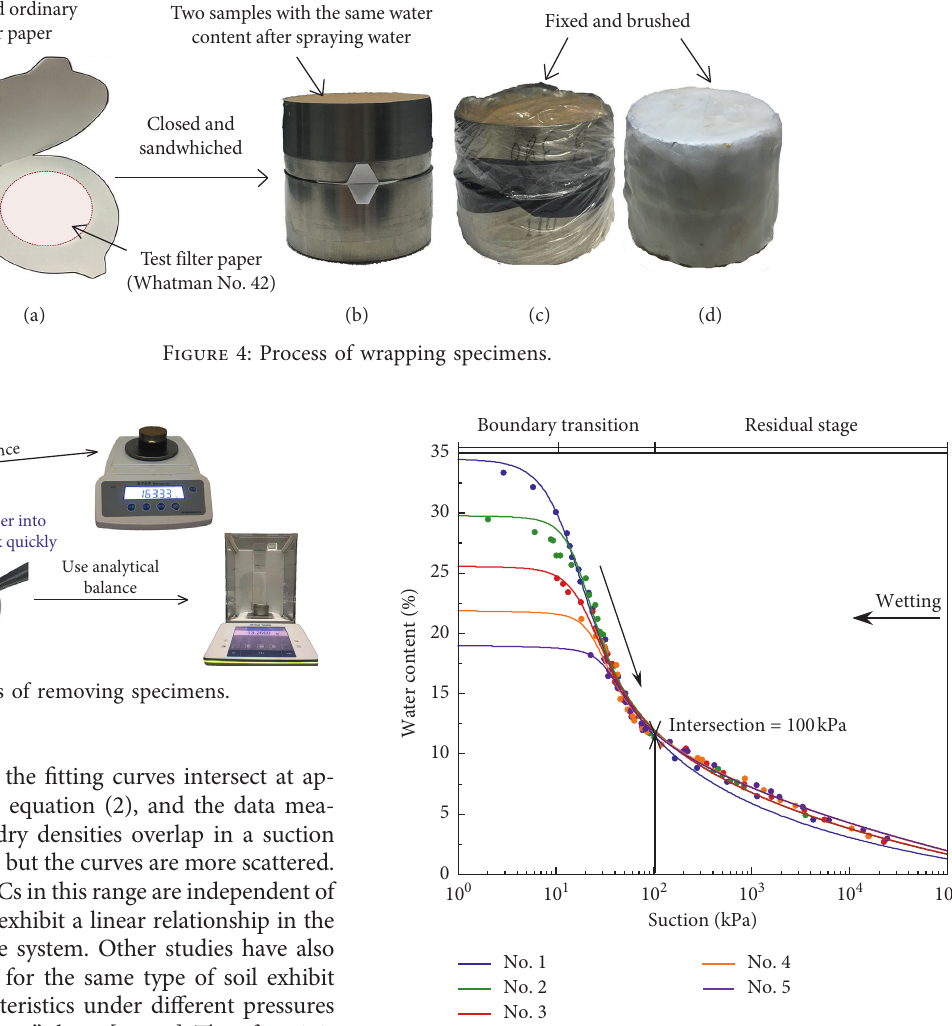
Figure 6: Test data and fitting curves of five specimens using Fredlund et al. [16]